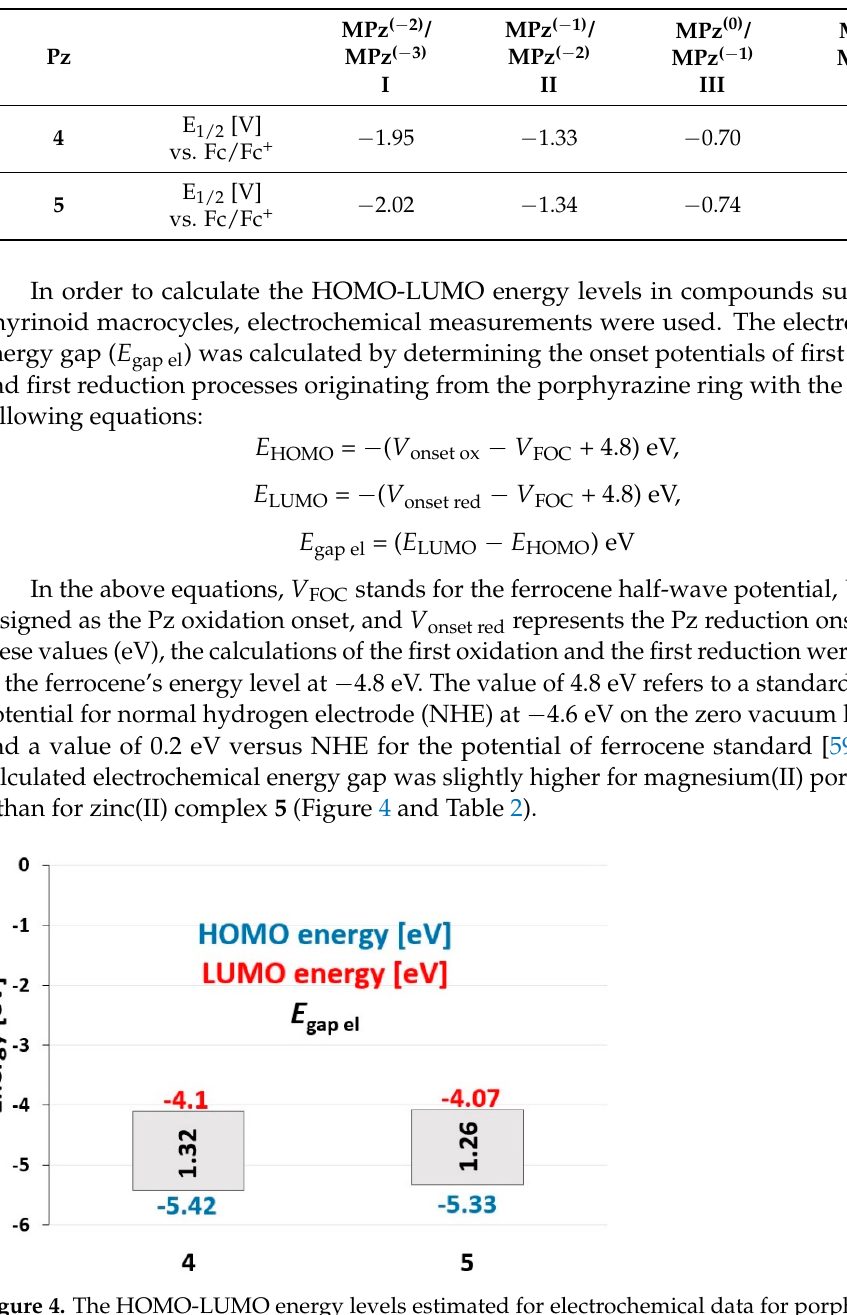
Figure 4. The HOMO-LUMO energy levels estimated for electrochemical data for porphyrazines 4 and 5 .